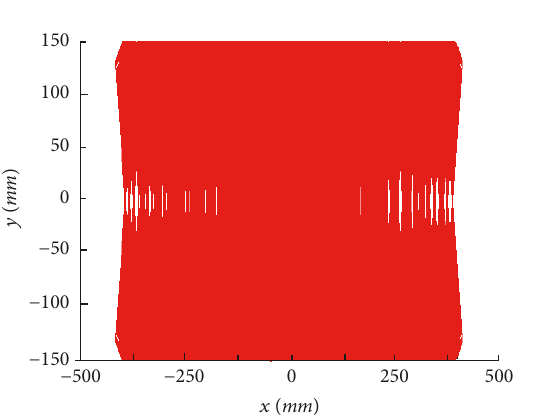
Figure 9: The workspace of the mechanism in 𝑥 − 𝑦